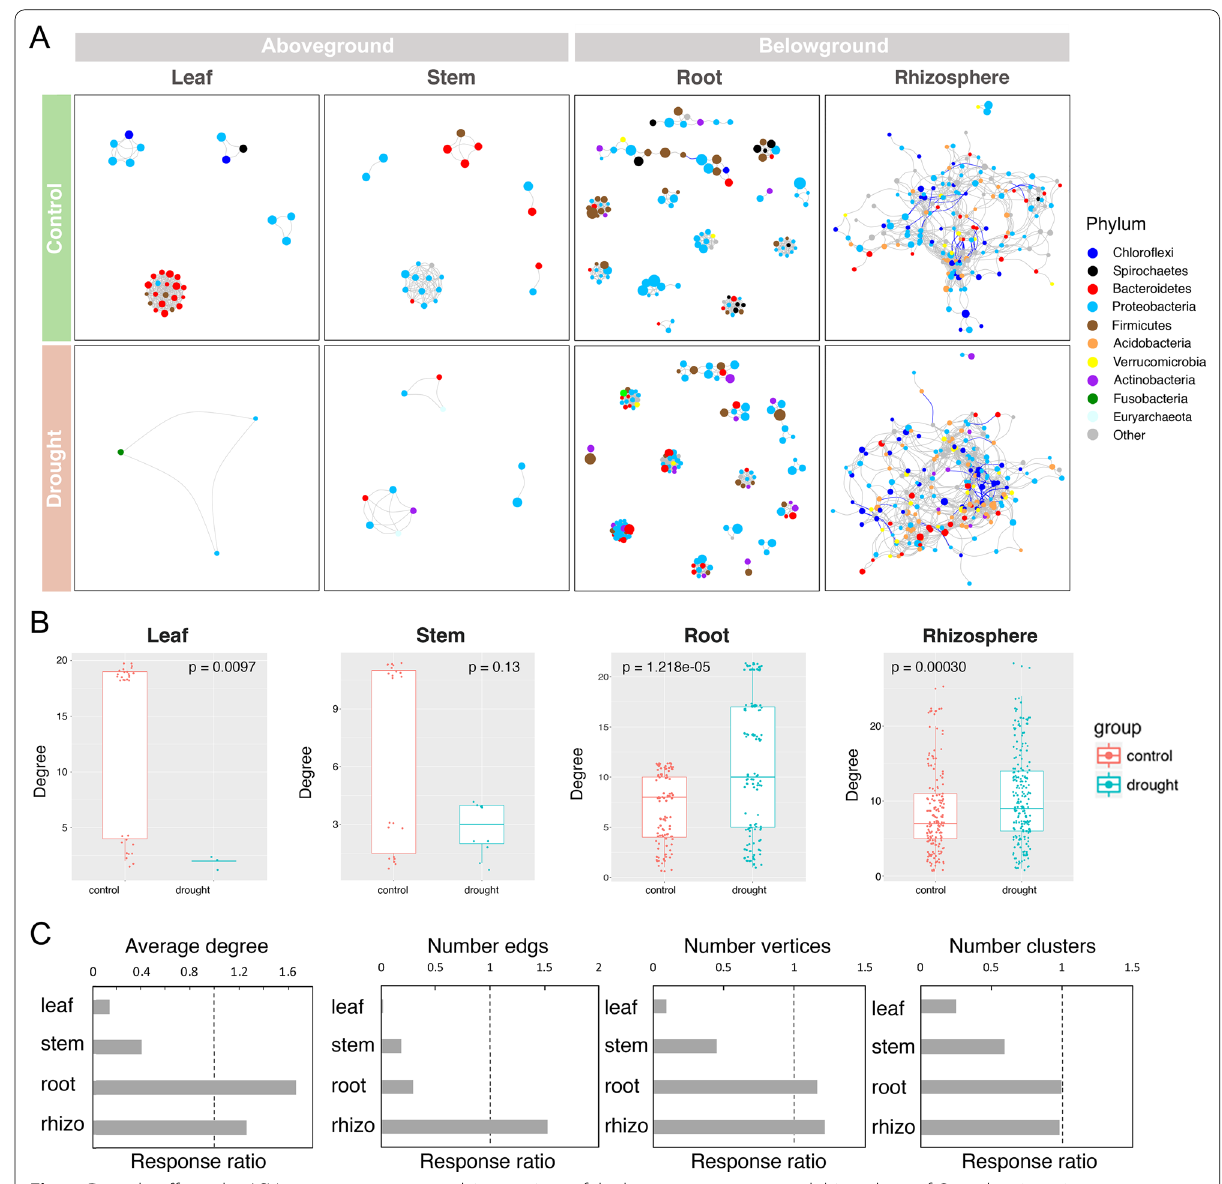
Fig. 4 Drought affects the ASV co-occurrence network interactions of the leaves, stems, roots, and rhizosphere of Oryza longistaminata . Co-occurrence relationships with strong Spearman’s correlation values ( p value < 0.5 and abs(r) > 0.6) are depicted for each compartment. The nodes represented a unique ASV in the data sets. A ASV co-occurrence network is affected by drought. Networks are colored by phylum and sized based on the relative abundance of the ASV (log10-fold change in relative abundance). The negative correlations of edges are colored blue. B Node degree of the co-occurrence network. C Response ratios (treatment/control) of the average degree, number of edges, vertices, and clusters